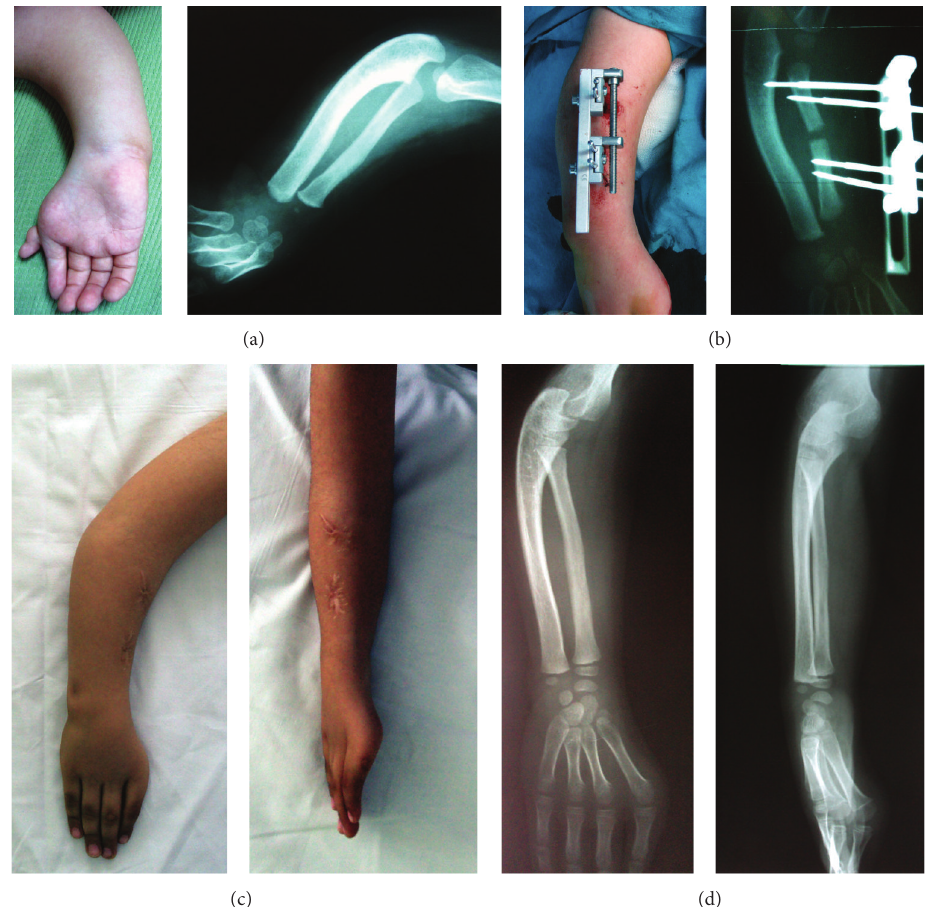
Figure 3: The preoperative, intraoperative, and postoperative images of the third case. (a) Preoperative and (b) intraoperative ((c), (d)) images of patients after implants were removed. the wrist and forearm rotation was significantly